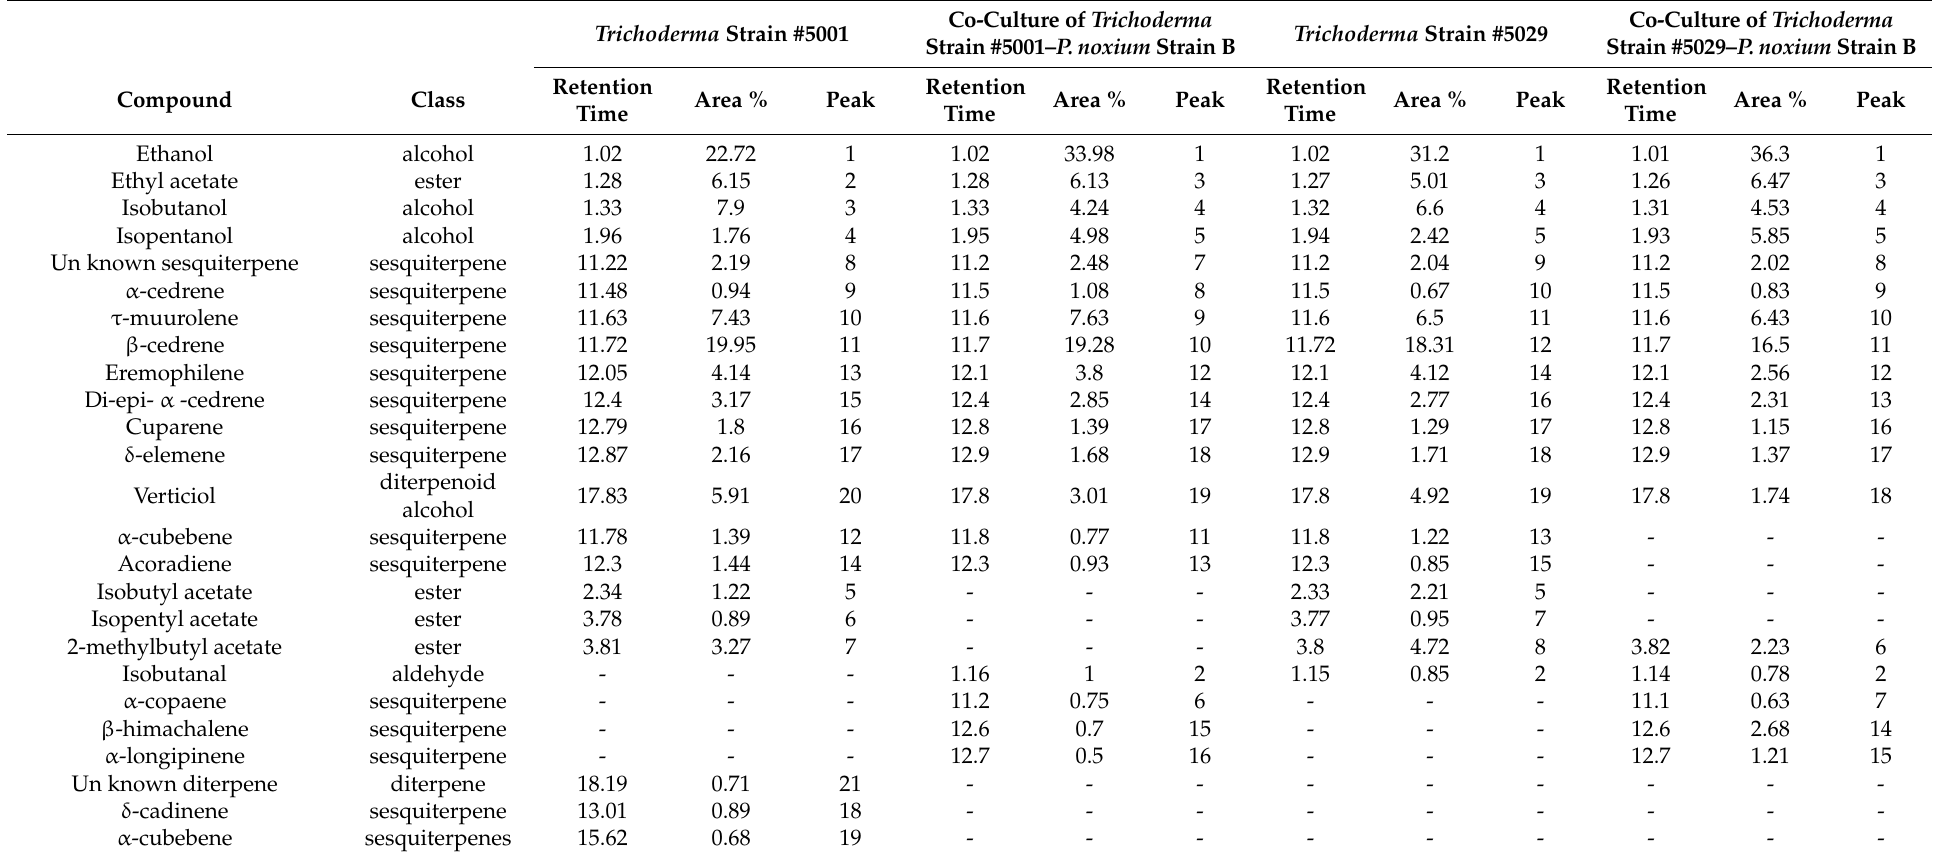
Table 2. Changes in the volatile compounds produced by Trichoderma strains before and after the confrontation with P. noxium tentatively identified through SPEM GC/MS